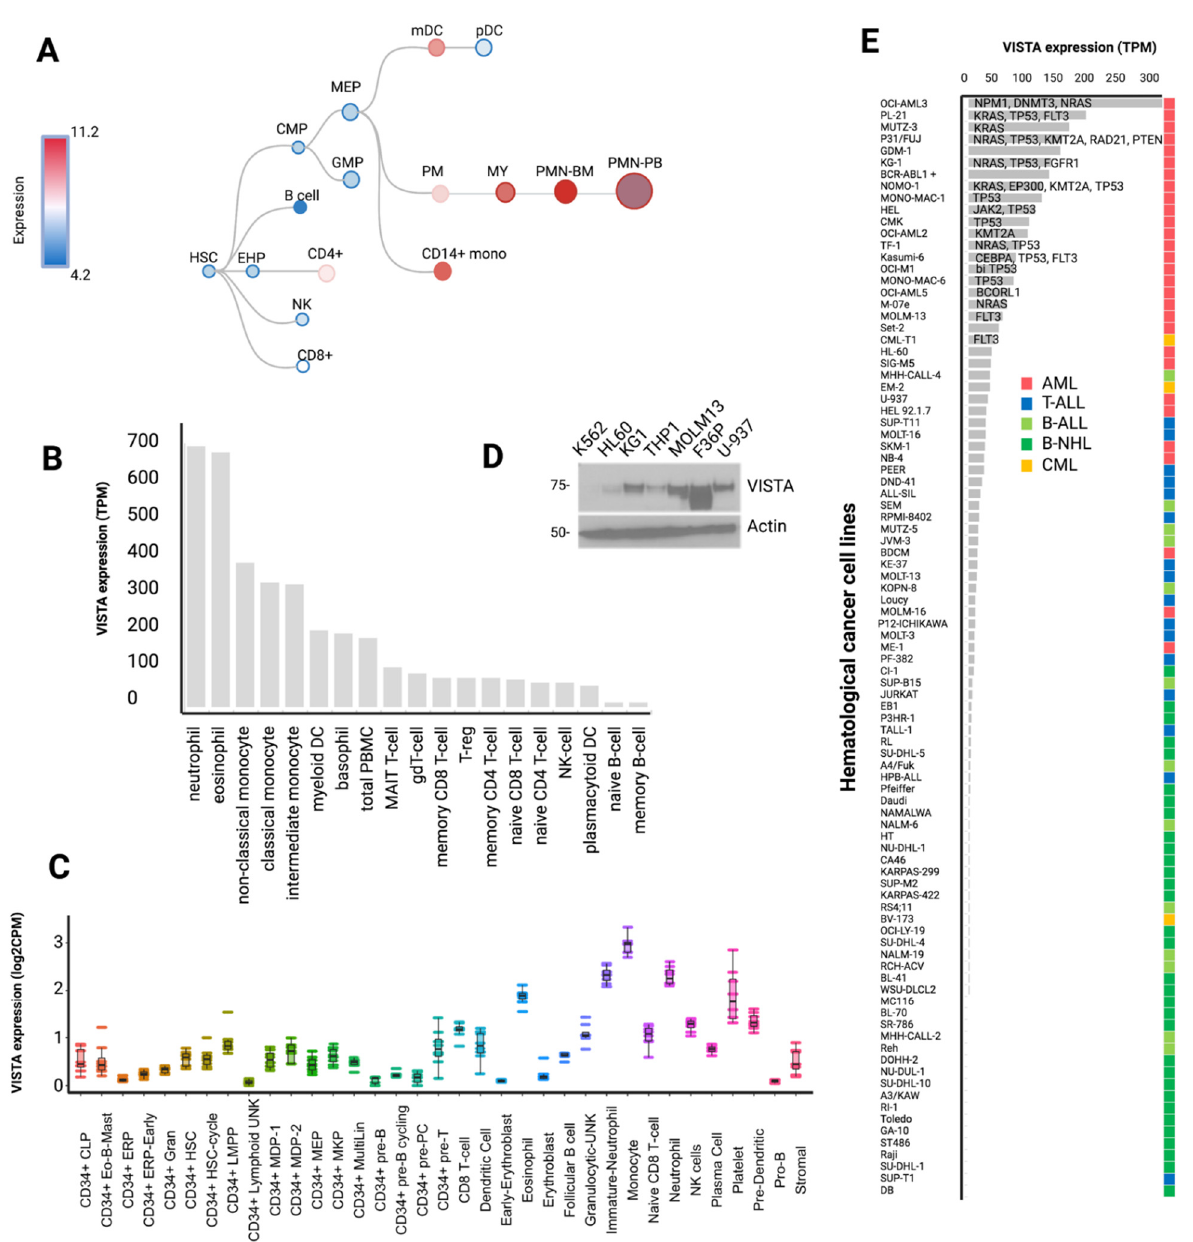
Figure 2. VISTA transcriptomic profile in normal hematopoiesis and in hematological cancer cell lines. ( A ) Vista differentiation tree across hematopoietic cell differentiation (data retrieved and adapted from https://servers.binf.ku.dk/bloodspot/, 28 January 2022). ( B ) Bar plot showing the distribution of VISTA expression values (as transcripts per million, TPM) across several mature peripheral blood cell populations. Raw data were retrieved from https://www.proteinatlas.org/about/download, 21 December 2021. ( C ) Box plot displaying the distribution of VISTA expression values (TPM) across 35 bone marrow cell types (raw data retrieved from http://www.altanalyze.org/ICGS/HCA/Viewer.php, 13 September 2021). ( D ) Western blot showing VISTA protein abundance in several hematological cell lines. ( E ) Bar plot of VISTA expression across hematological cancer cell lines (data retrieved from https://www.ebi.ac.uk/gxa/experiments/E-MTAB-2770/Downloads, 13 September 2021). The text indicates the name of mutated genes in each cell lines. Only representative cell lines are reported.